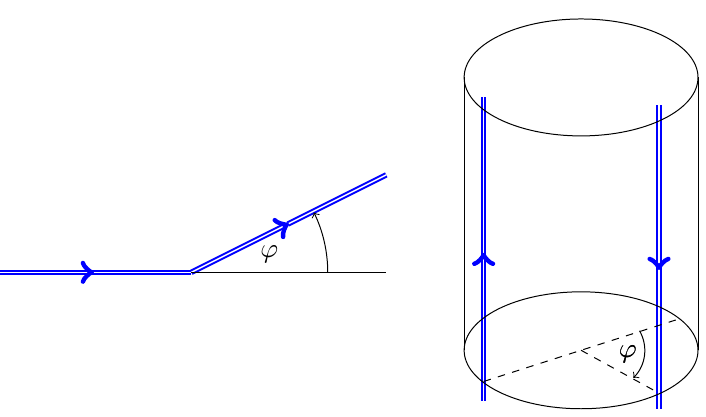
Figure 1 . The cusp setting on the plane and on the cylinder. The two con(cid:12)gurations are mapped to each other by a conformal transformation and this relates the cusp anomalous dimension to the quark-antiquark potential for any conformal gauge